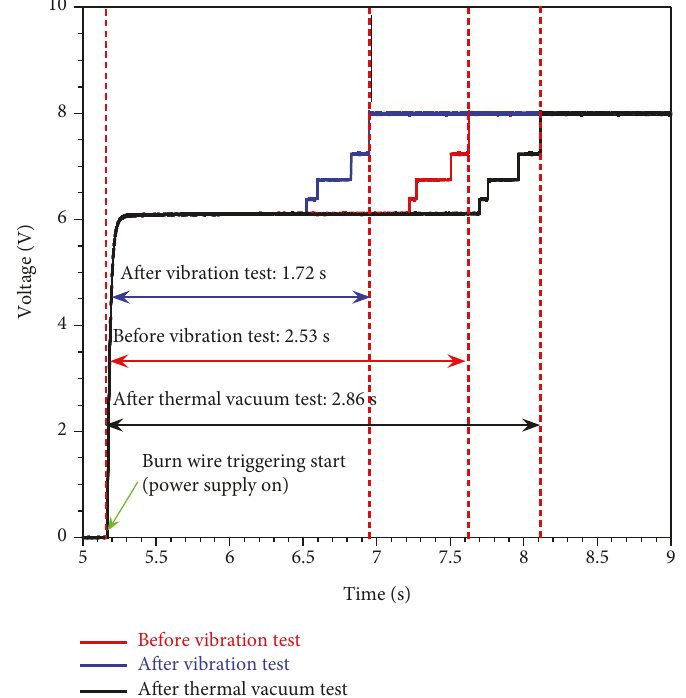
Figure 15: Comparison of the release time of the mechanism measured before the vibration test, after the vibration test, and after the TV